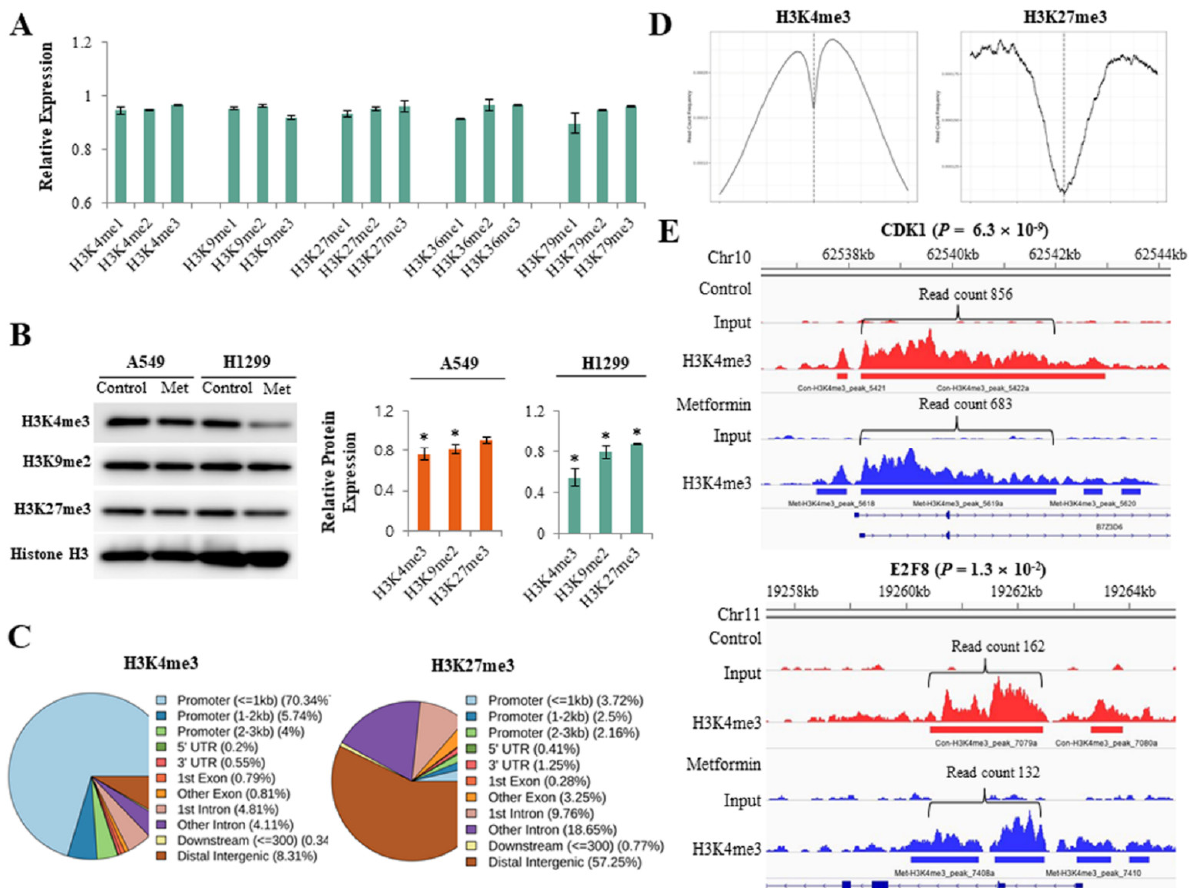
Figure 1 . Effects of metformin on histone H3 modifications. H1299 and A549 cells were treated with 5 mM metformin or left untreated as controls. ( A ) Global alterations in histone H3 methylations were analyzed using an enzyme-linked immunosorbent assay. The y -axis indicates the amounts of proteins in metformin-treated cells relative to untreated cells. Error bars indicate the standard deviation ( n = 3). ( B ) Protein levels of H3K4me3, H3K9me2, and H3K27me3 were analyzed by western blotting. The bar graphs show the expression of three proteins in cells treated with 5 mM metformin relative to untreated cells. Error bars indicate the standard deviation ( n = 3, * p < 0.05). The uncropped blots of ( B ) were shown in Figure S1. ( C ) The results from the ChIP-seq analysis show DNA regions in which H3K4me3 or H3K27me3 modification were enriched in response to metformin. ( D ) The read count frequency of H3K4me3 or H3K27me3 within the transcription start site (TSS) ± 3 kb is shown. ( E ) The images show ChIP-seq peaks of two representative genes whose H3K4m3 was reduced by metformin. Peaks indicate read count frequency.